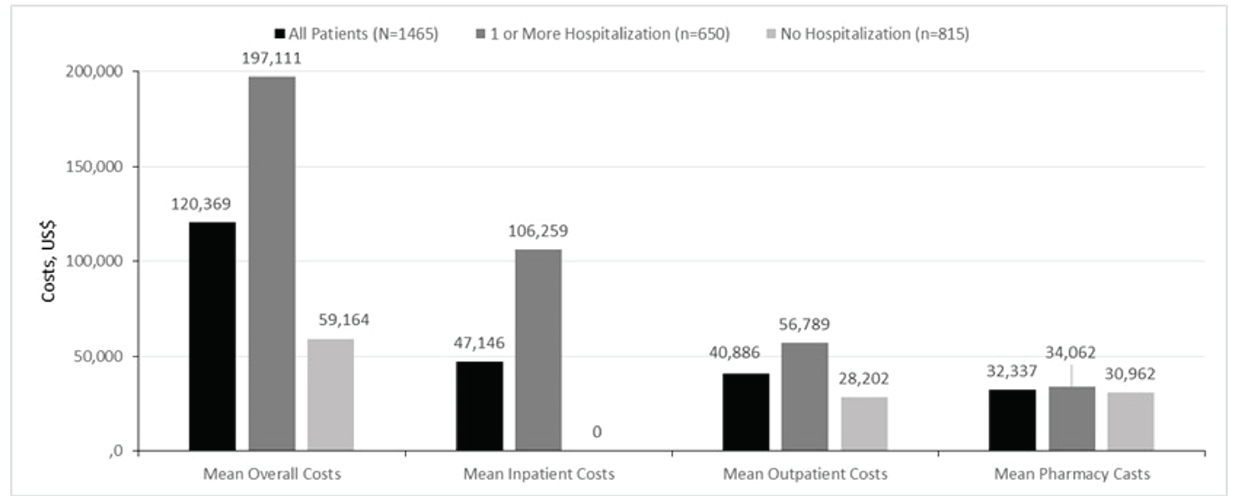
Figure 5. Healthcare Costs Overall and for Patients with/without at Least One Hospital Admission